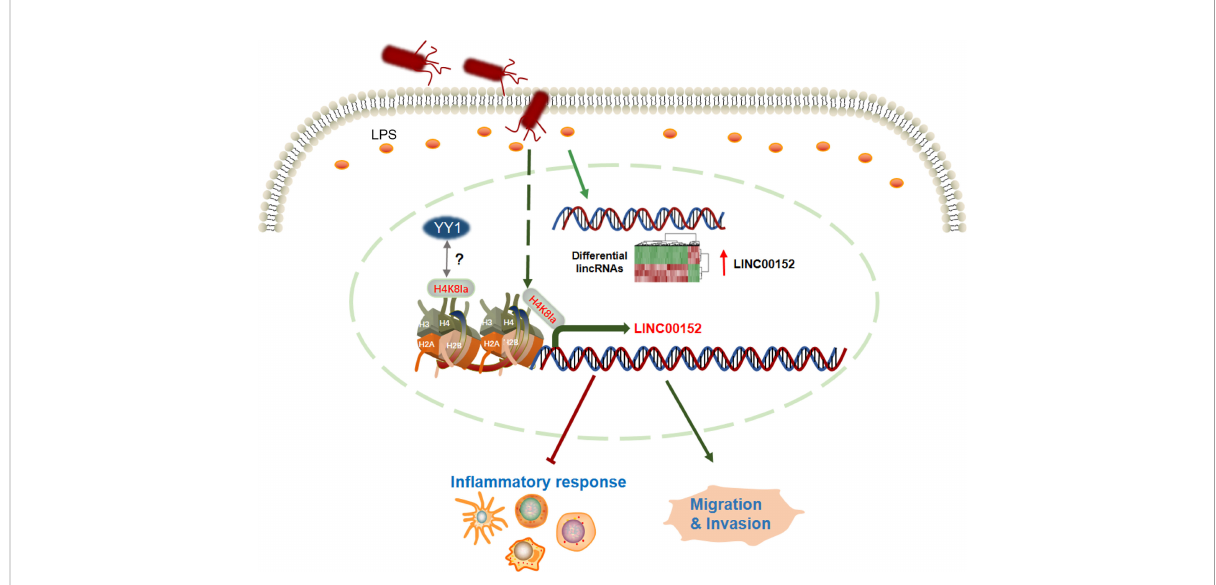
FIGURE 5 The graphic summary of this study. The enterobacterial LPS induced widespread expression alteration of lncRNAs, including LINC00152. The bacteria-derived LPS upregulates the expression of LINC00152 by introducing histone lactylation on its promoter, and decreasing the binding ef fi ciency of YY1 to it. The LPS-induced overexpression of LINC00152 was linked to the in fl ammation response and cancer cells migration and